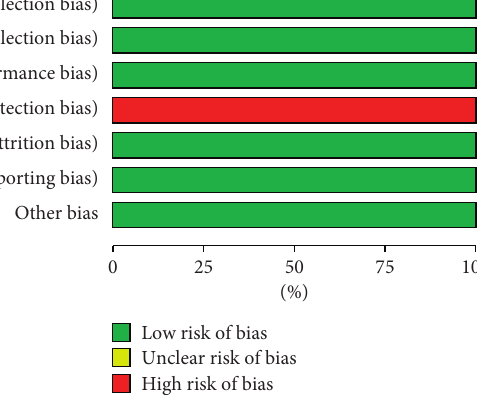
Figure 2: Graph illustrating risk of bias.